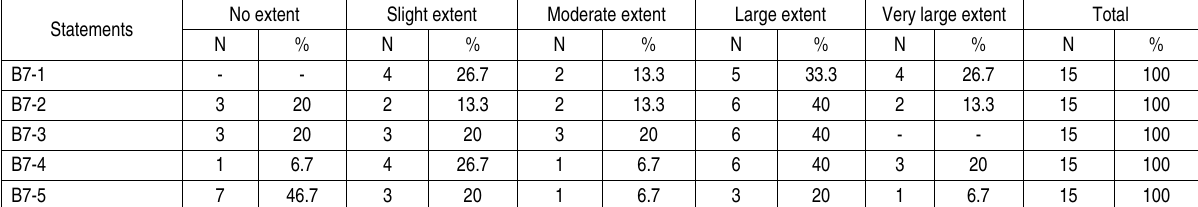
Table 8. Perceptions of respondents on the statement relating to disposal